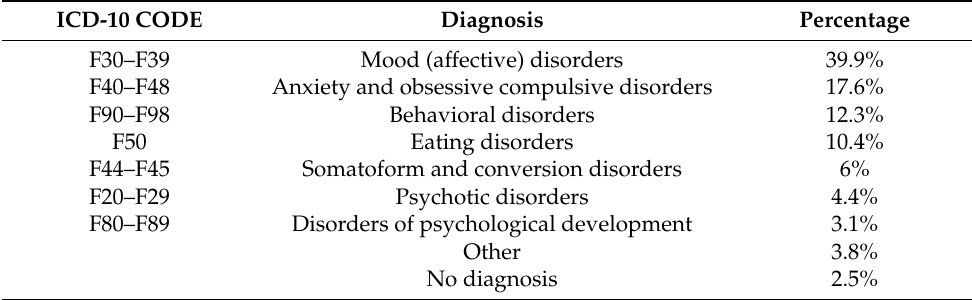
Table 1. Total percentage frequency of discharge diagnosis